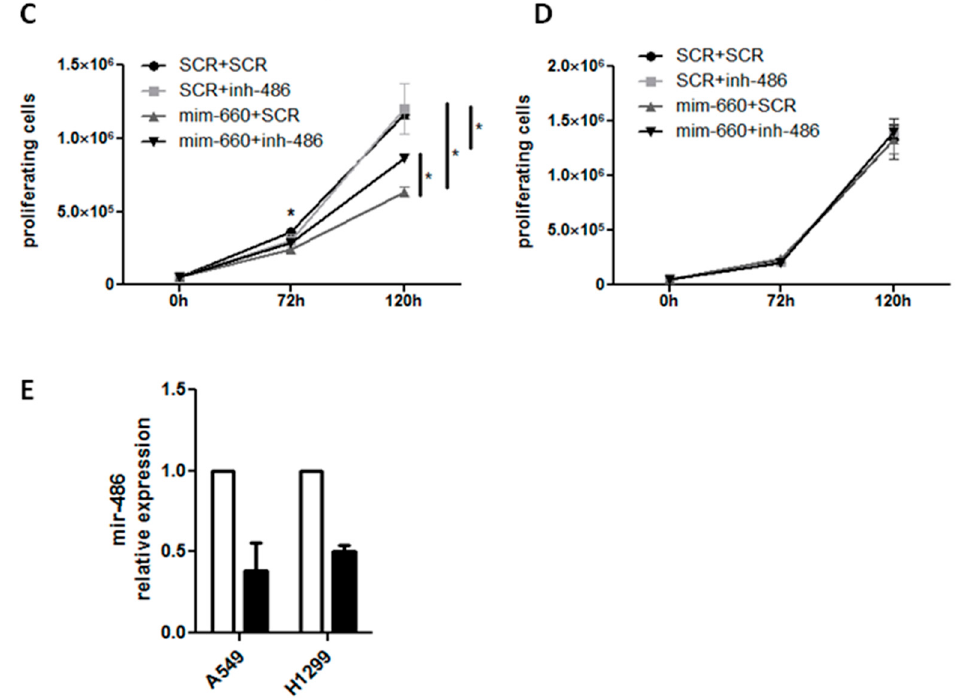
Figure 2. mir-486-5p is critical for mir-660-5p anti-tumoral effects in lung cancer cells. ( A , B ) Graphs showing A549 ( A ) and H1299 ( B ) migration in a Transwell assay after mir-660-5p over-expression and/or mir-486-5p inhibition ( n = 3). Migration is expressed as the number of migrated cells for each transfection vs. the number of migrated control cells; ( C , D ) graphs show the number of proliferating A549 ( C ) and H1299 ( D ) cells transfected with mir-660-5p mimic and/or mir-486-5p inhibitor or control and viable cells were counted with trypan blue at 72 and 120 h ( n = 3); ( E ) mir-486-5p expression levels after locked nucleic acid (LNA) inhibition (black bars), compared to untreated controls (white bars). All data are expressed as mean ± SEM. * p < 0.05 vs. controls.